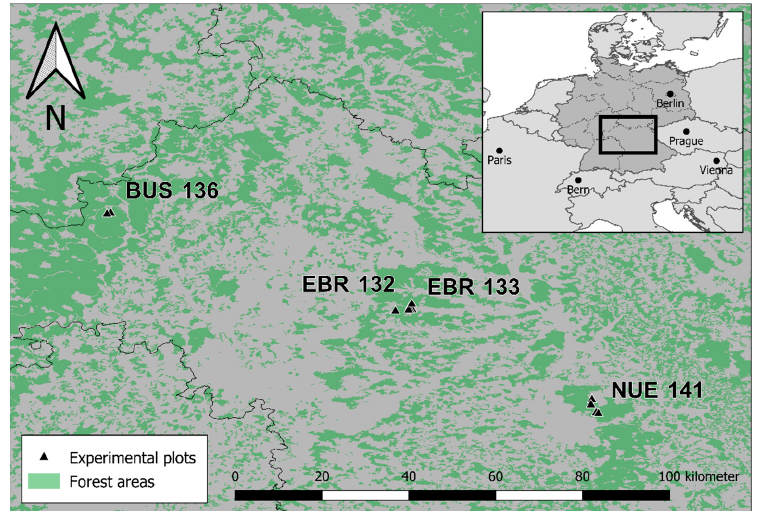
Figure 1. Geographic location of the experimental plots in southern and central Germany.